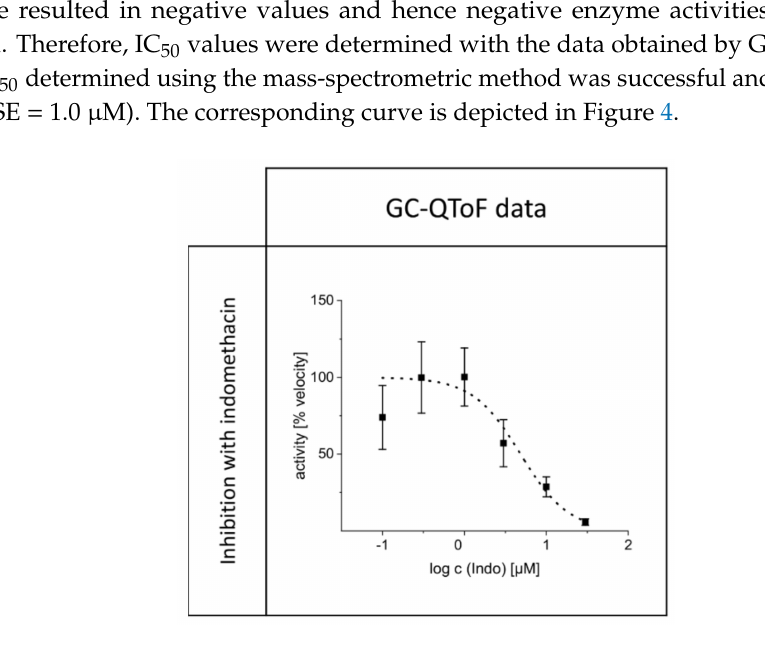
Figure 4. Inhibition curve generated from GC-QToF data: IC 50 = 4.8 µ M (SE = 1.0 µ